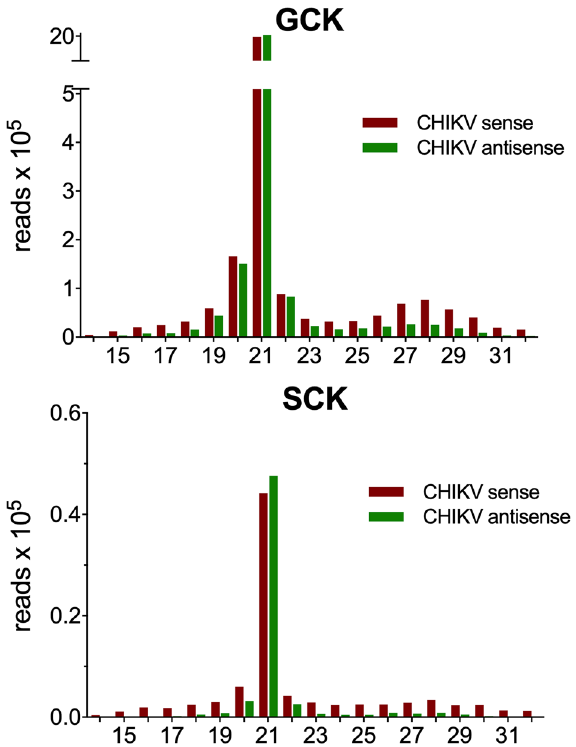
Figure 2. Size distribution of CHIKV-specific small RNAs in infected Ae. aegypti salivary glands and saliva. The number of reads mapping to the CHIKV genome (red) and antigenome (green) are reported on the Y-axis whereas the X-axis indicates the length in nucleotides of the small RNAs. GCK, CHIKV-infected salivary glands; SCK, CHIKV-infected